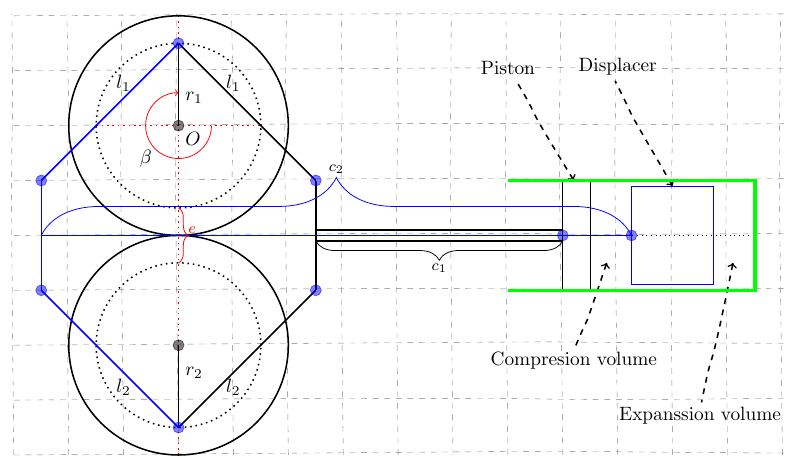
Figure 5. Beta configuration with rhombic drive.